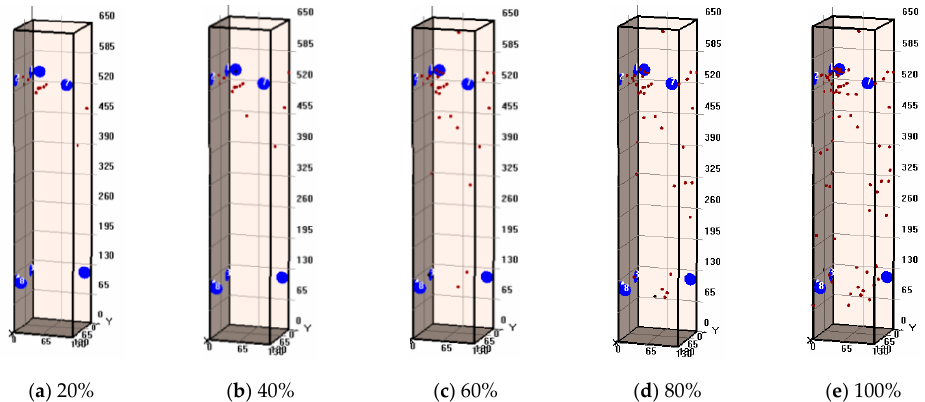
Figure 18. Testing results of AE events location at stages for corroded specimens with different load levels (a) 20%; (b) 40%; (c) 60%; (d) 80%; (e) 100% load levels.